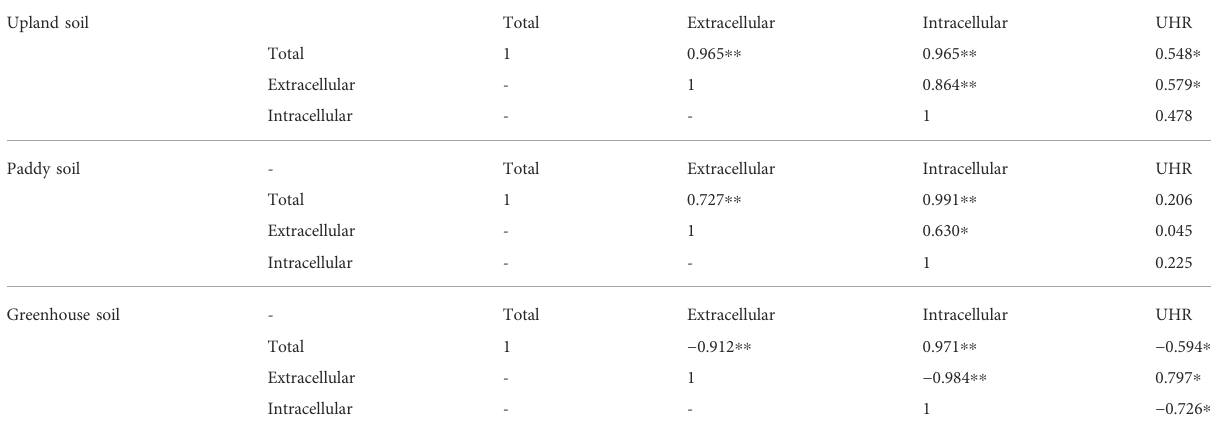
TABLE 2 Correlations between the urea-N hydrolysis rate and urease activity of various pools. Upland